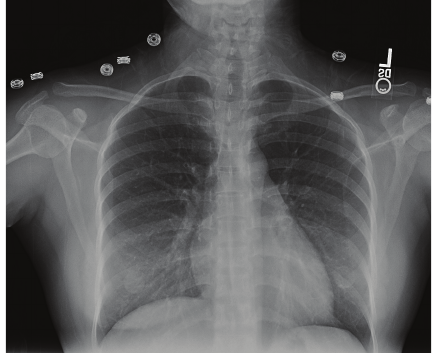
Figure 2: Chest X-ray showing resolution of pulmonary congestion 3 days after